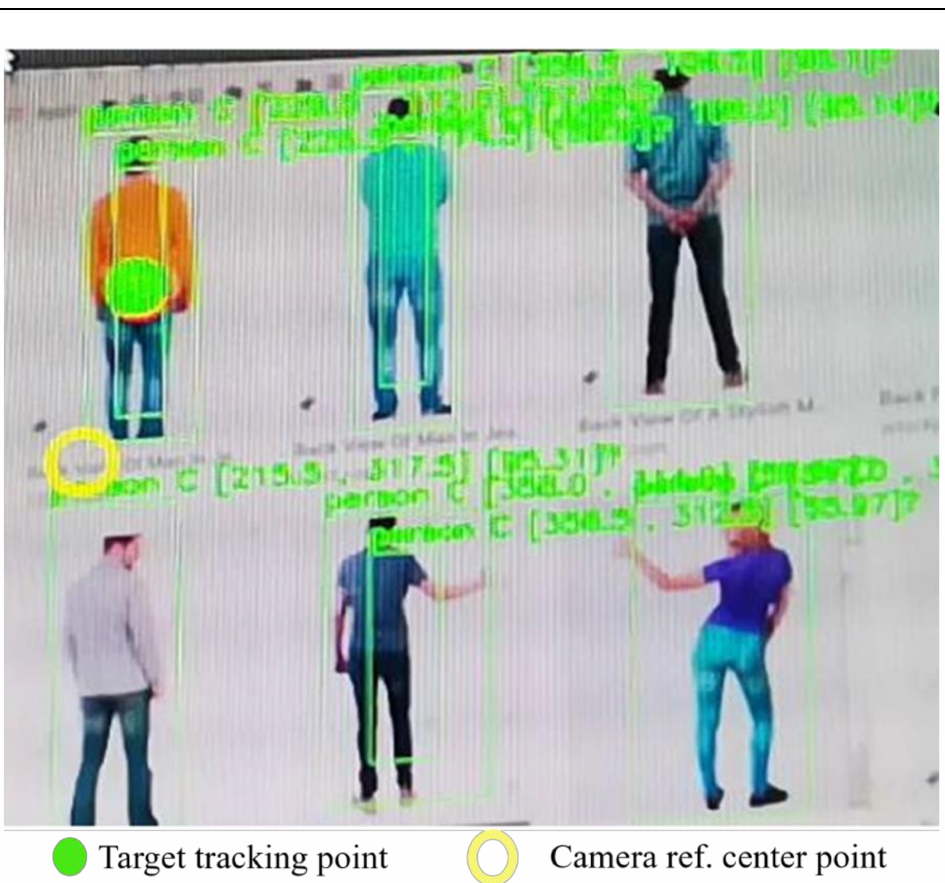
Figure 17. Experimental test of the adaptive target